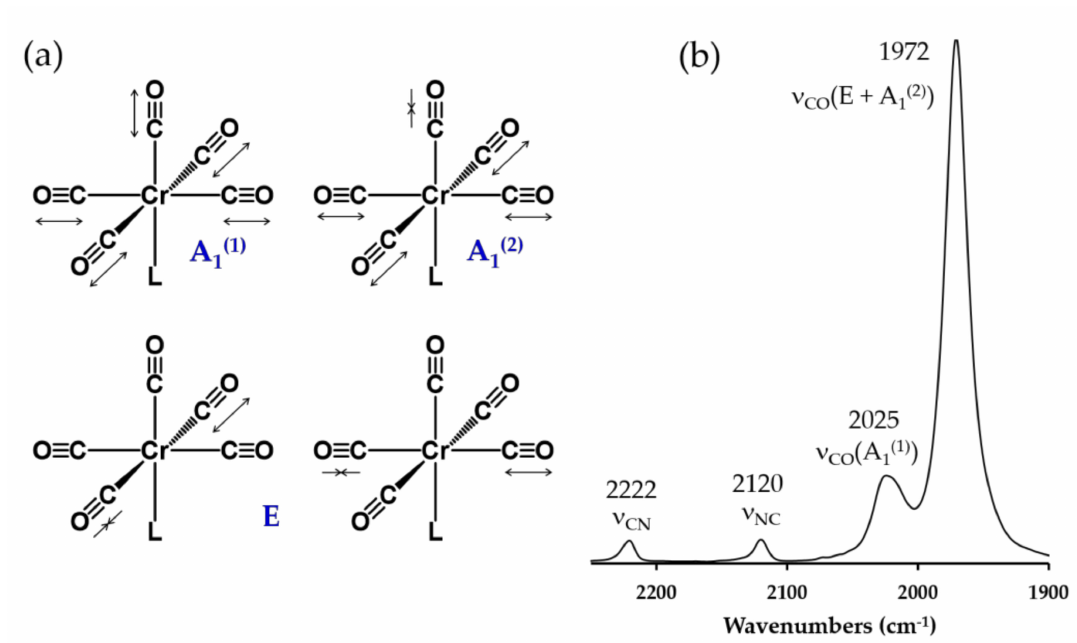
Figure 8. ( a ) IR-active υ C ≡ O vibrational modes for [M(CO) 5 L]; ( b ) FTIR spectrum of 10 in CH 2 Cl 2 .